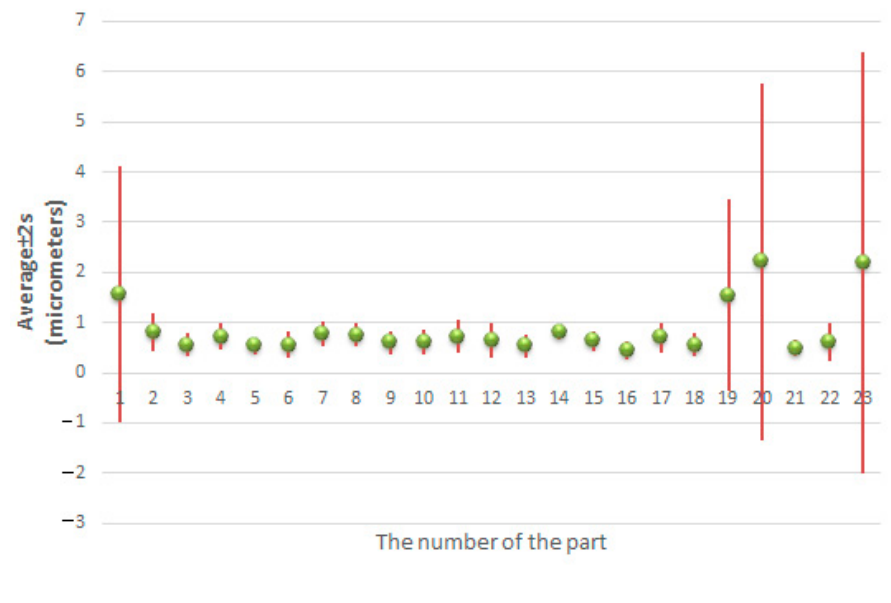
Figure 13. Average values of the roundness deviation and their confidence levels (calculated as ± 2 s ) for each sphere from the first dataset.